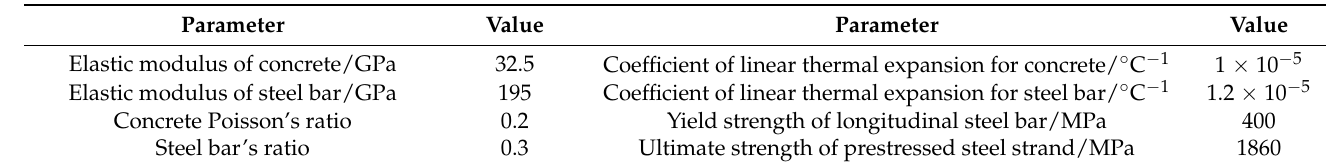
Figure 5. Finite element model of YKJ1. Table 2. Material parameter values for the finite element